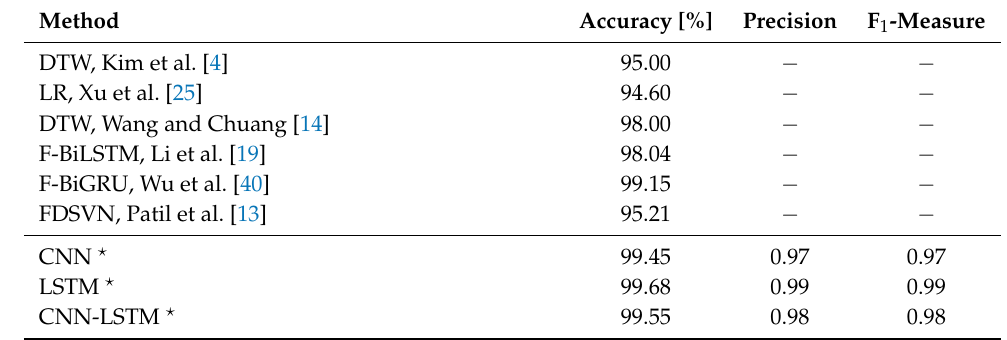
Table 5. Comparison with the state-of-the-art related methods.